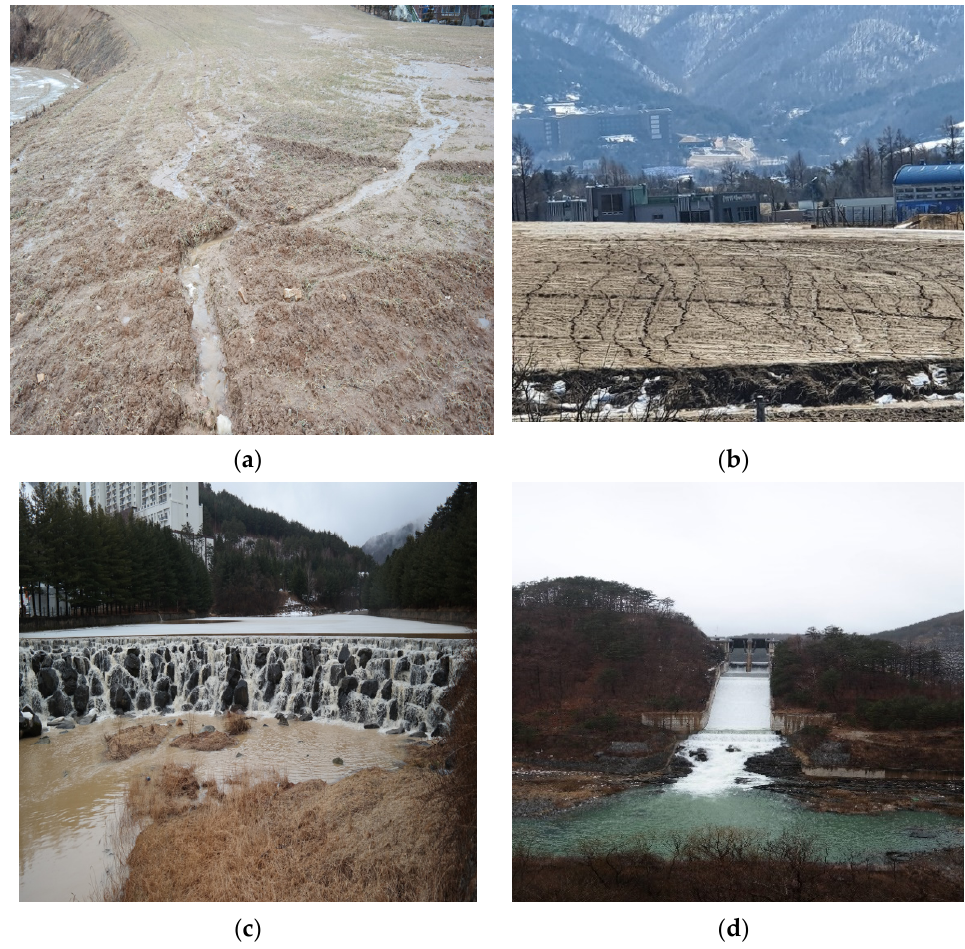
Figure 6. Selected site photos of the field surveys; ( a ) A-01, ( b ) B-06, ( c ) C-03, ( d ) D-01.